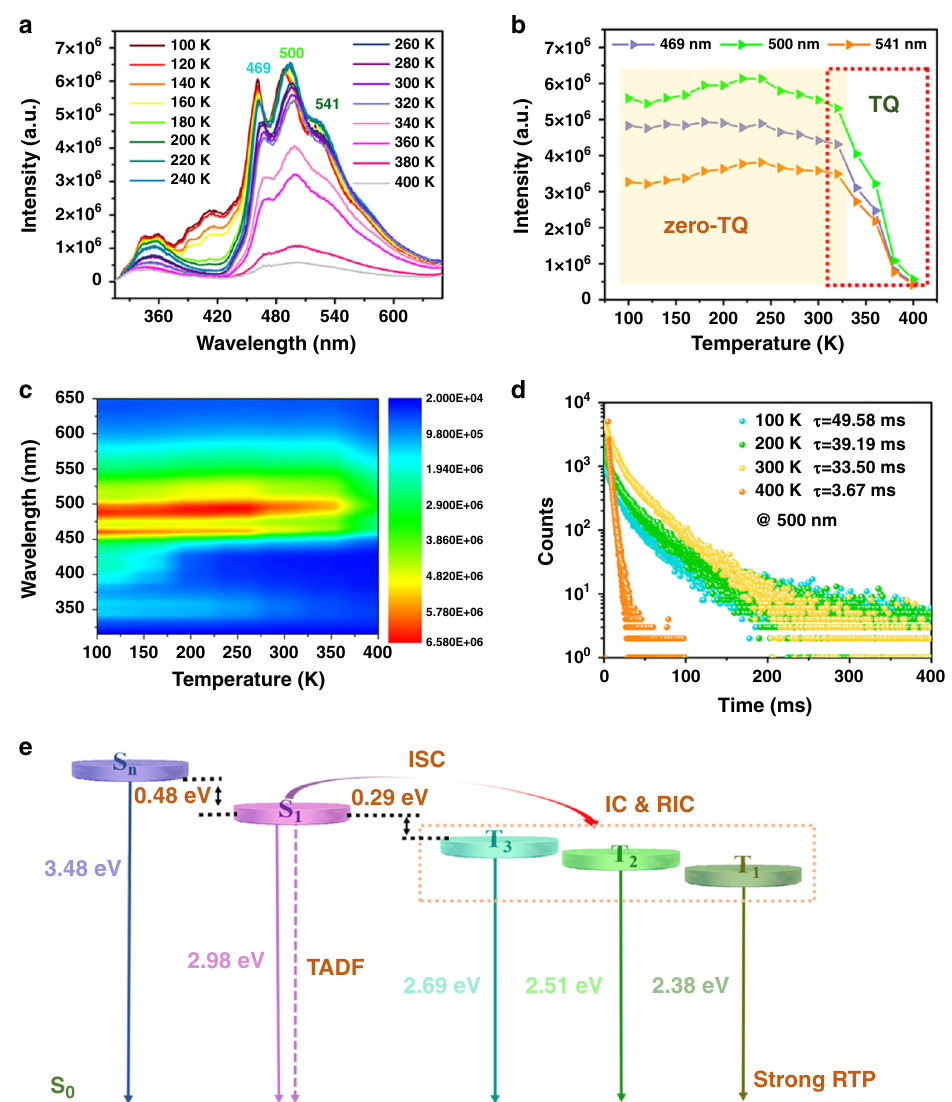
Fig. 3 Emission spectra of (Ph 4 P) 2 Cd 2 Br 6 under different temperatures and the analysis. Solid-state emission spectra of a (Ph 4 P) 2 Cd 2 Br 6 at different temperatures between 100 and 400 K upon excitation at 300 nm. b Temperature-dependent intensity of emission (469 nm, 500 nm, 541 nm) from 100 to 400 K. c Two-dimensional map of the PL spectra of (Ph 4 P) 2 Cd 2 Br 6 under the prompt mode at different temperatures ranging from 100 to 400 K. d Time- resolved PL decay curve of (Ph 4 P) 2 Cd 2 Br 6 at different temperatures. e Energy levels of different states (calculated with phosphorescence peak at 100 K).